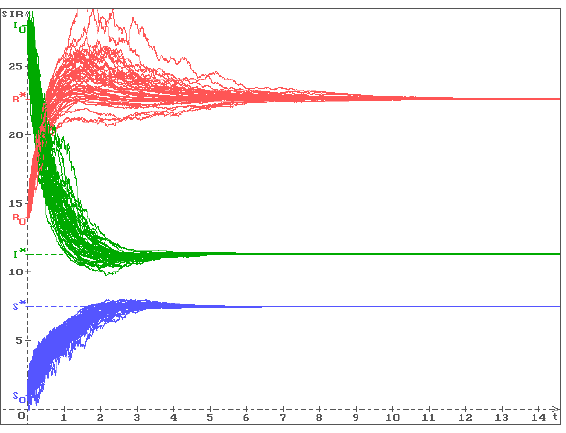
Figure 3. Fifty trajectories of the solution of the system (6) solution: S ( t ) (blue), I ( t ) (green), R ( t ) (red) with the initial values S ( 0 ) = 1, I ( s ) = 28, s ∈ [ − h ,0 ] , R ( 0 ) = 14 in the point Q ( δ 1 , δ 2 ) = Q ( 1.69,0.49 ) , δ 3 = 0.45, h = 0.1.